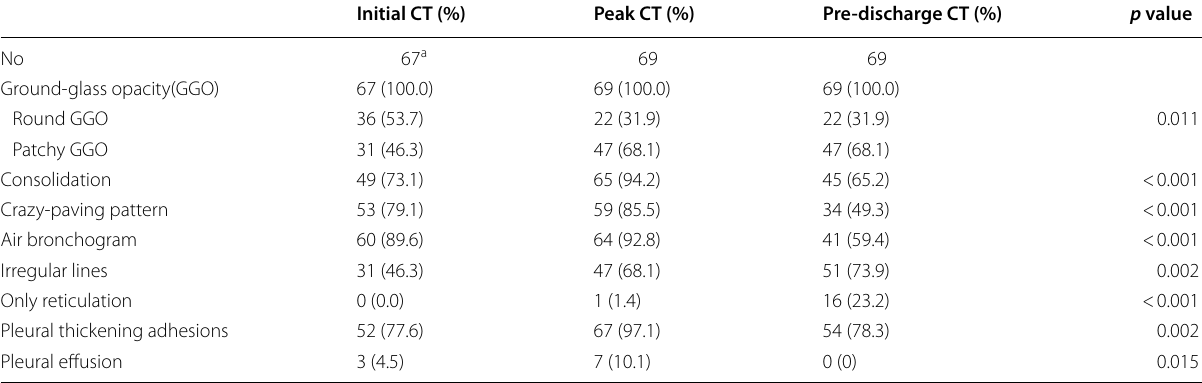
Table 3 Comparison among imaging findings of initial, peak, and pre‑discharge CTs of COVID‑19 during